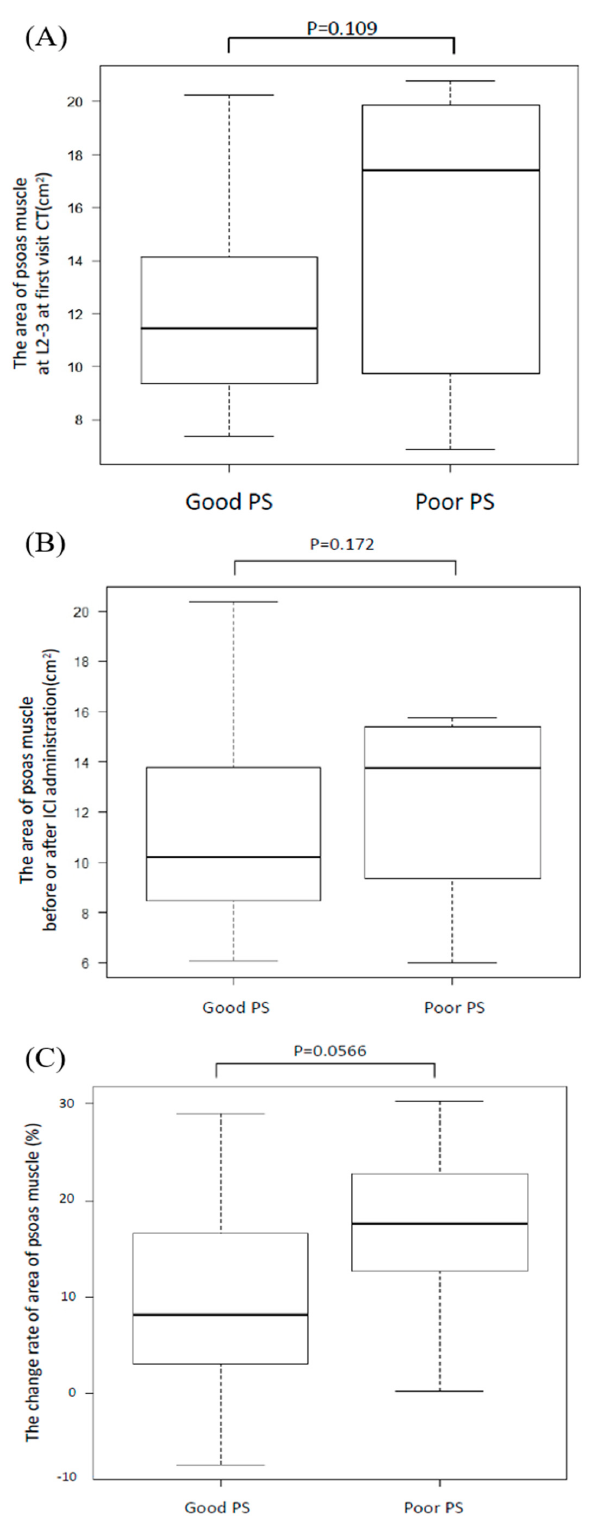
Figure 3. Area of psoas major muscle at the L2–L3 position for the good PS and poor PS groups. We divided patients into good PS (less than one) or poor PS groups (more than two) and compared their psoas major muscle areas (PMMAs). There was no significant di ff erence at the first visit CT ( A ) or before ICI treatment ( B ). Moreover, we evaluated the change rate of area of psoas muscle between good PS patients and poor PS patients. It has turned out that poor PS group tended to be higher the change rate than good PS group ( C